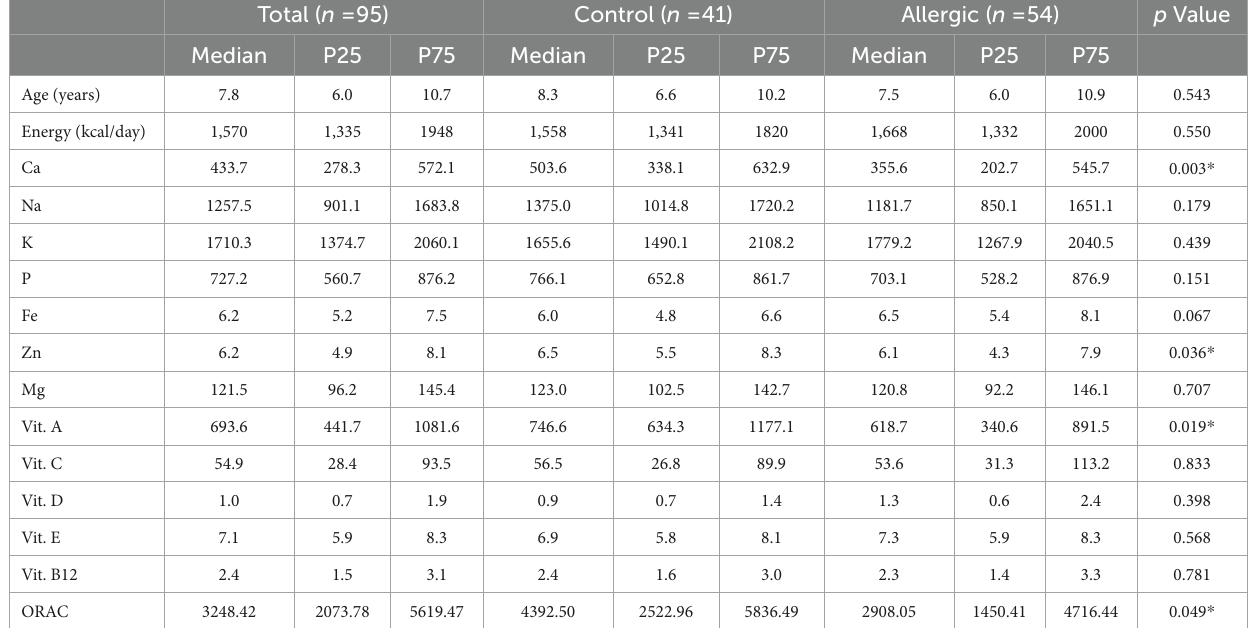
TABLE 2 Energy and micronutrient intakes of children with and without food allergies.